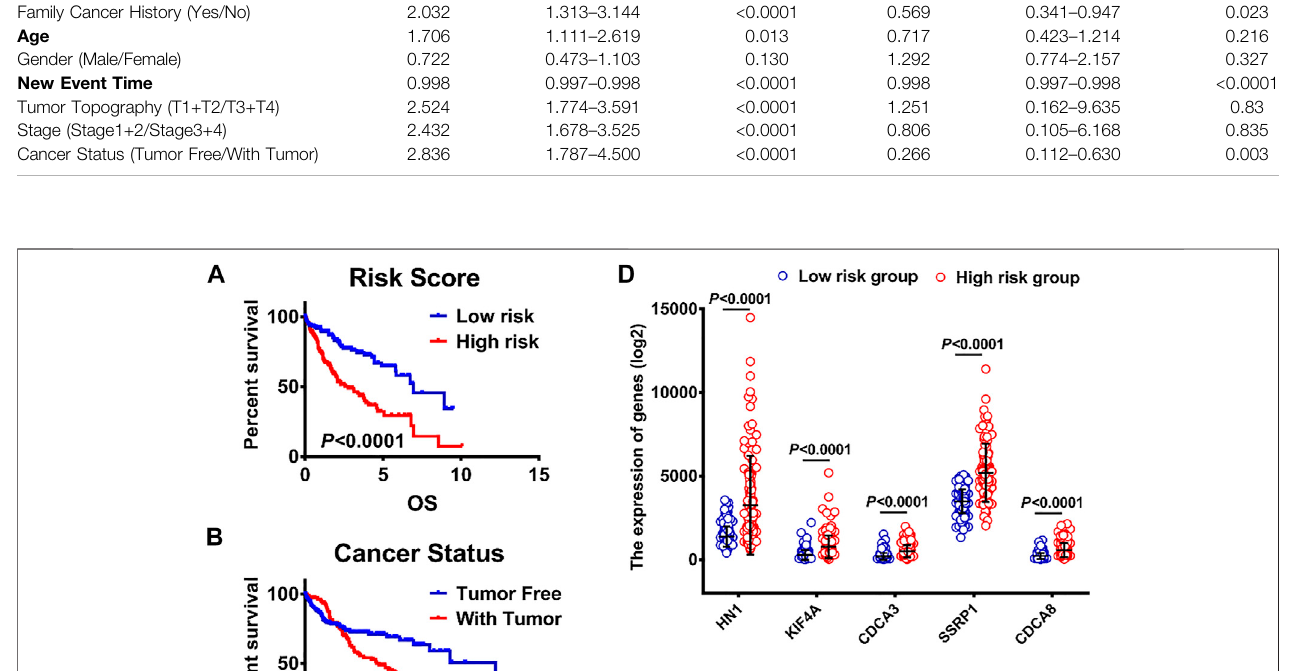
Frontiers in Genetics |